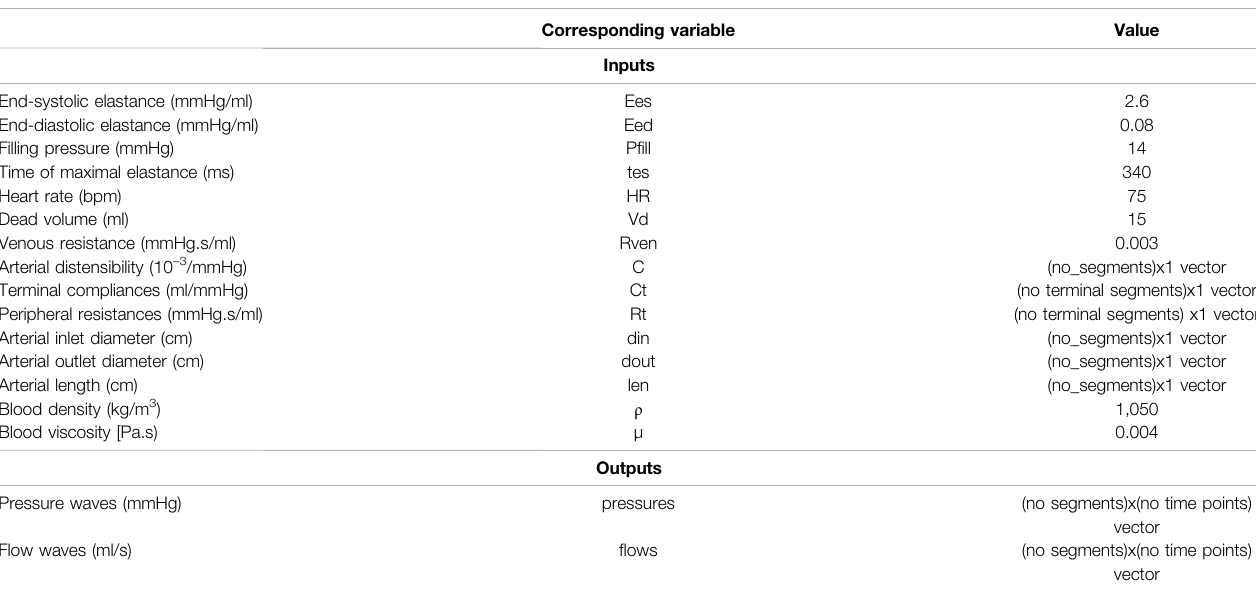
TABLE 1 | List of inputs and outputs of the 1-D cardiovascular